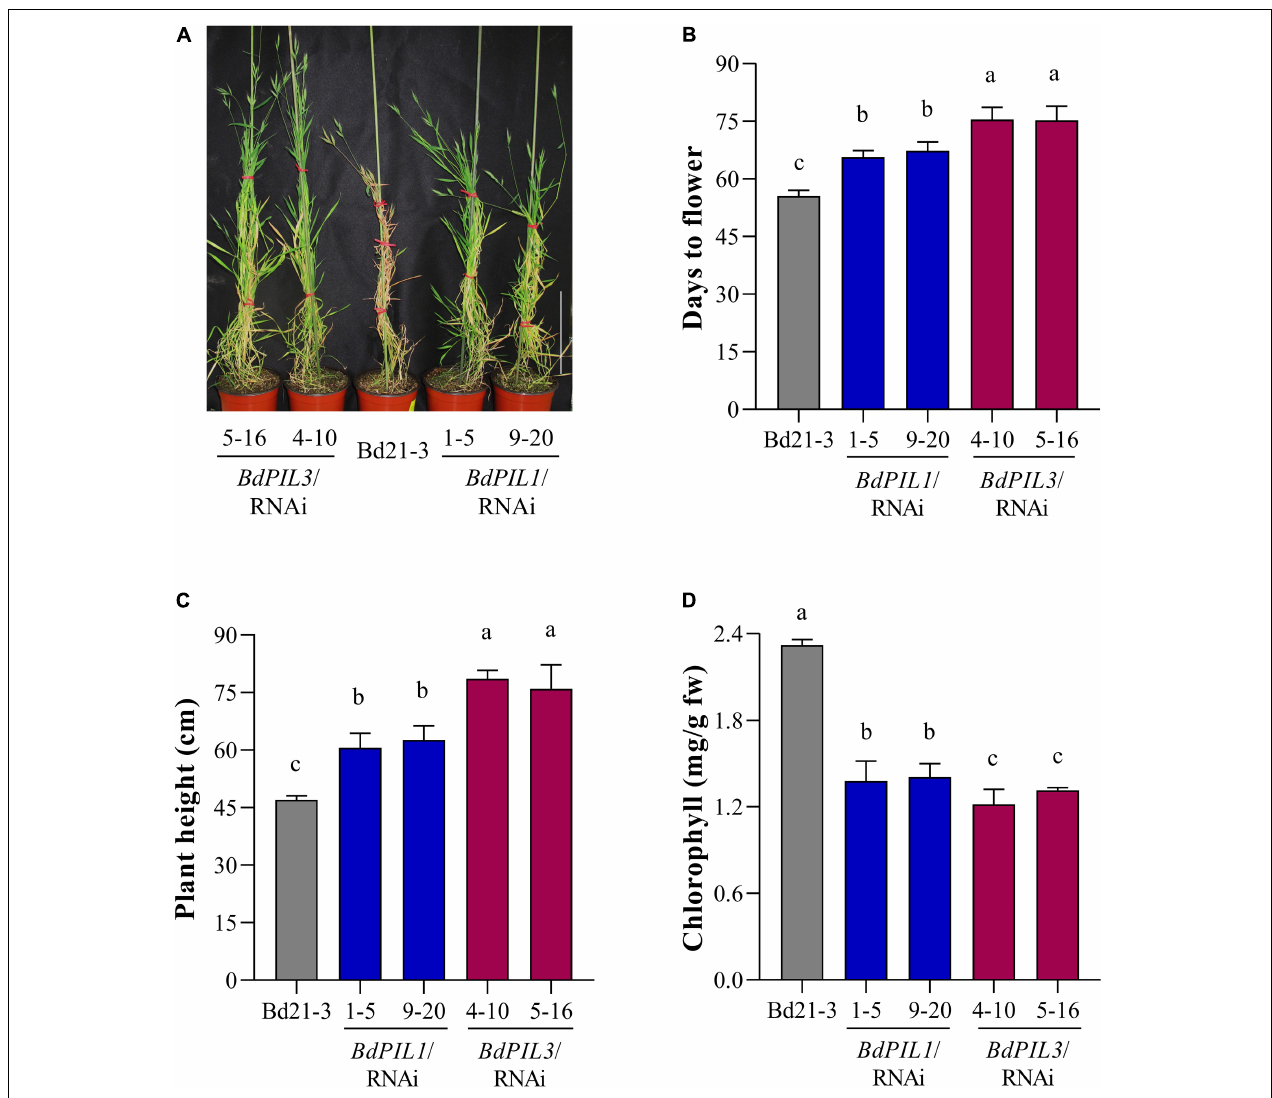
FIGURE 3 | Phenotypic characterization of BdPIL1 /RNAi and BdPIL3 /RNAi plants. (A) Representative 80-day-old plants grown at 22 ◦ C under long day conditions (18-h light/6-h dark cycle). Wild-type Brachypodium (Bd21-3) plant served as a control. Scale bar, 20 cm. (B) Analysis of flowering time. The average flowering time was estimated from germination to the heading day. (C) Average plant heights of 4-month-old plants. (D) Chlorophyll content analysis using leaves of 8-week-old plants. Data represent the means ± SD ( n ≥ 30 for C,D , n = 3 for D ), and different letters represent significantly different means ( P < 0.01, using Duncan’s multiple range